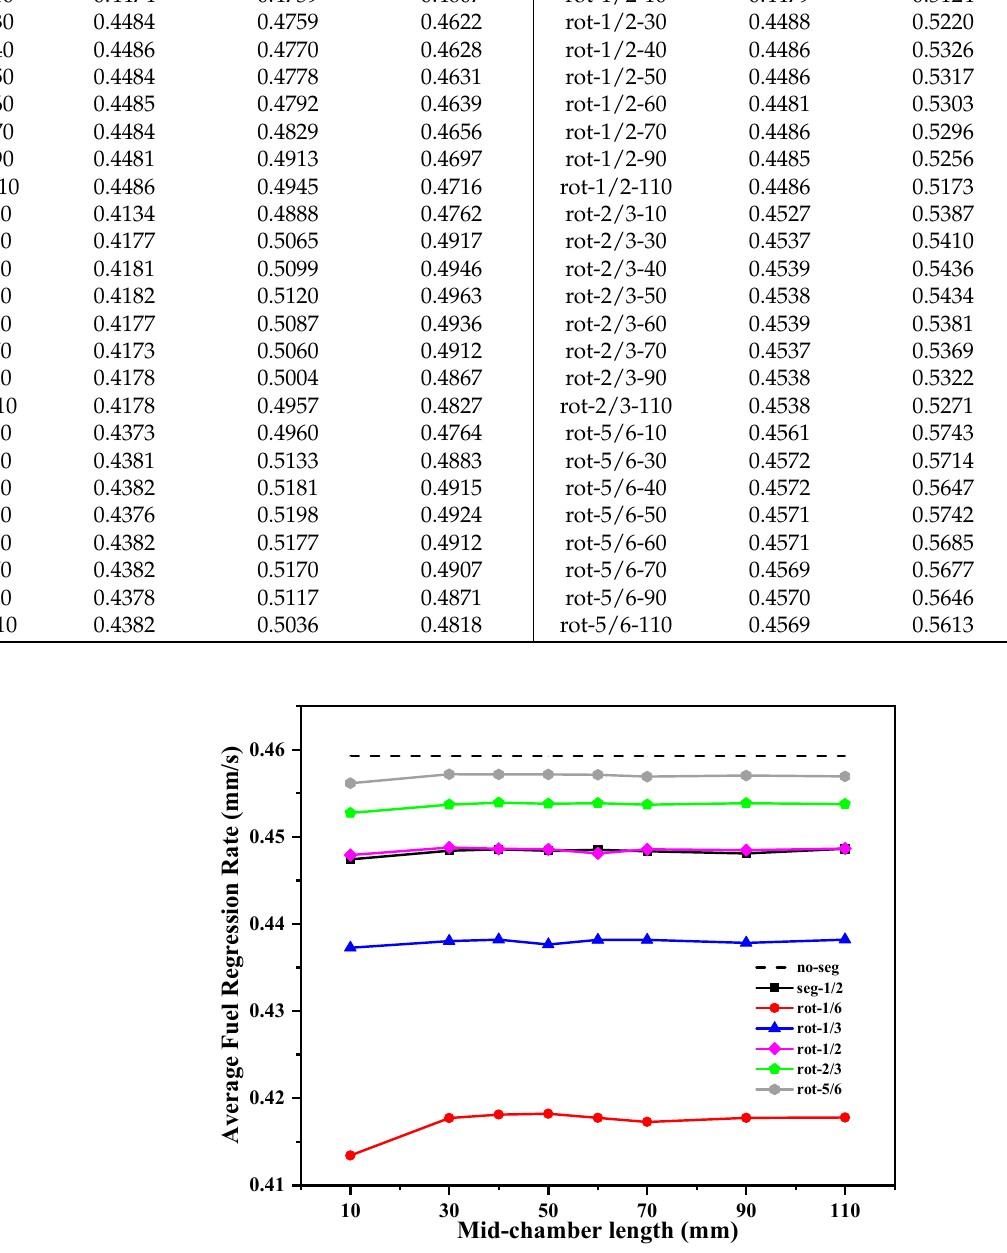
Figure 26. Average fuel regression rates in the aft-section grain for various cases. Figure 27. Average fuel regression rates of the whole grain for various cases. 3.3. Combustion Efficiency The combustion efficiency η can be calculated from: